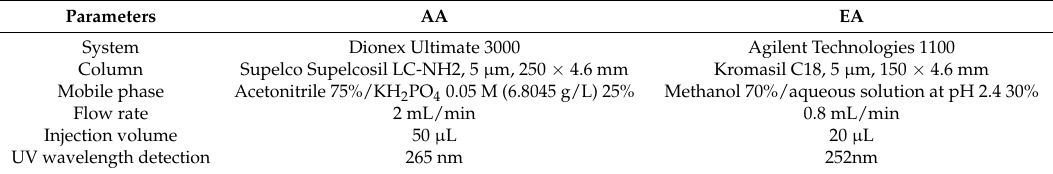
Table 1. HPLC conditions for the analysis of ascorbic acid (AA) and ellagic acid (EA).